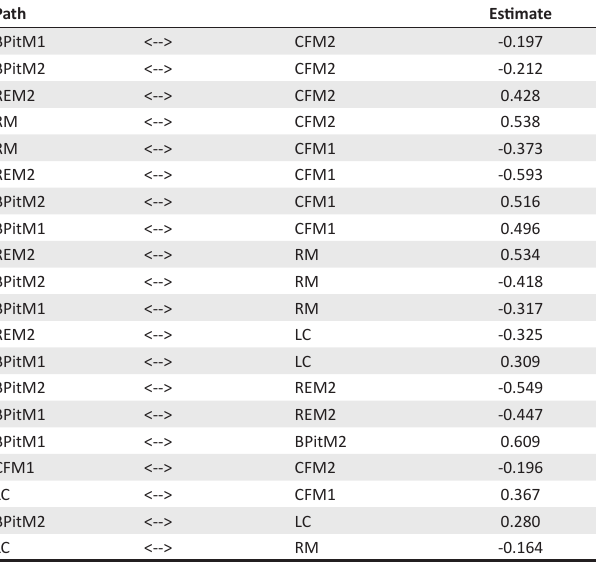
TABLE 10: Correlations for paired independent variables.